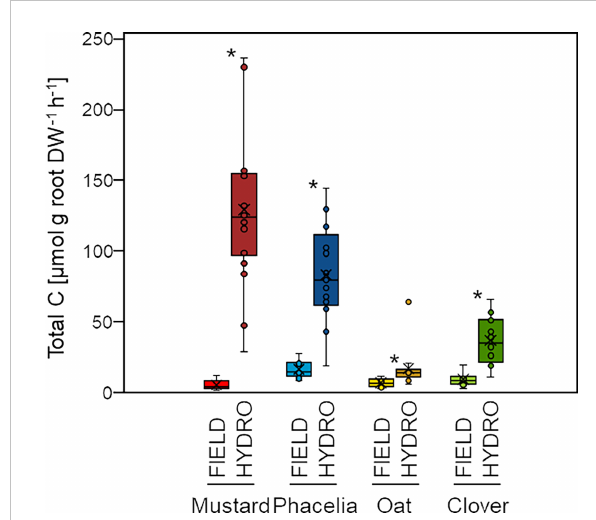
FIGURE 1 Recovery of total carbon in root exudates of cover crop roots in the fi eld (FIELD) and in hydroponic culture (HYDRO). Boxes show median, fi rst and third quartile, whiskers show minimum and maximum; a value is shown as outlier when it exceeds/undercuts the third/ fi rst quartile by more than 1.5x the interquartile range (n=9-11 [FIELD], n=18-21 [HYDRO]). Asterisks mark signi fi cant differences between FIELD and HYDRO within one species according to differences in estimated means extracted from model 1 at the 5% level of signi fi